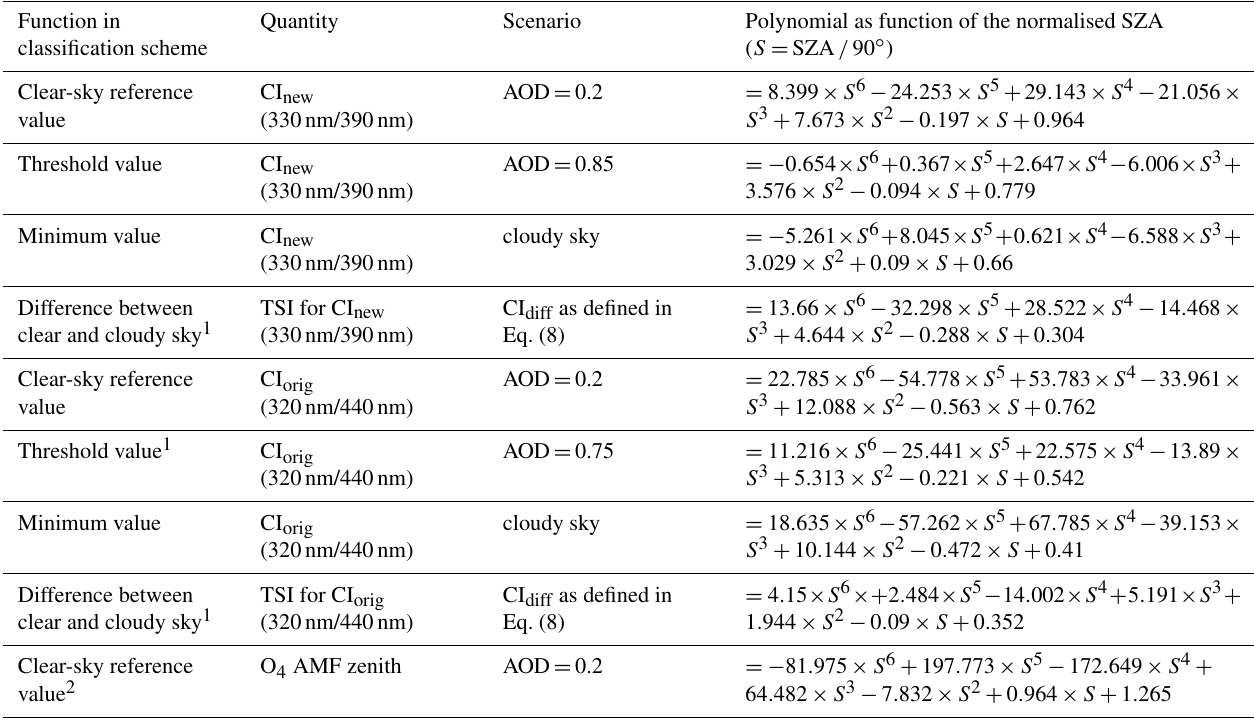
Table 2. Polynomial expressions for the different SZA-dependent clear-sky reference and threshold values. Function in Quantity Scenario Polynomial as function of the normalised classification scheme